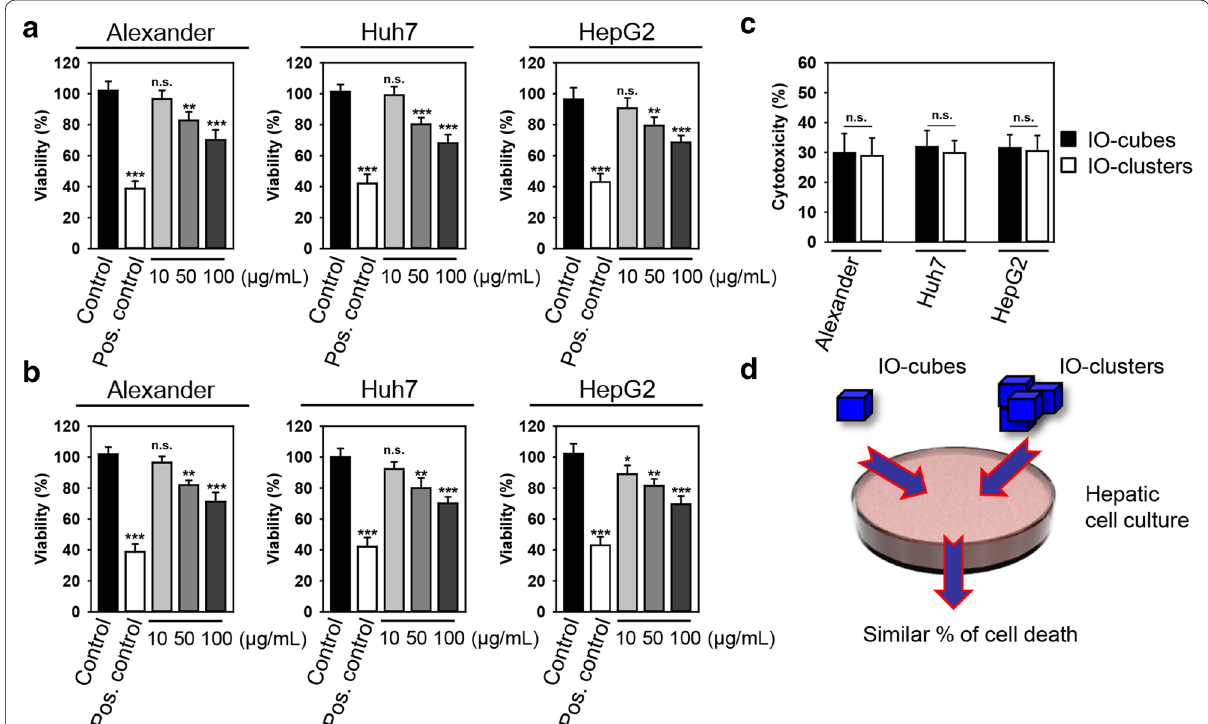
Fig. 3 Viability studies. Alexander, HepG2 and Huh7 cells were treated with indicated concentrations of either IO-cubes ( a ) or IO-clusters ( b ) for 48 h. The alamarBlue cell viability assay was used to assess degree of cellular viability. The data were normalized to control values (no particle exposure), which were set as 100% cell viability. Control cells were untreated. As a positive control, cells were treated with 20% ethanol for 60 min. Data are expressed as mean SEM (n 3), ** p < 0.01, *** p < 0.001. c Cell viability comparison among different hepatic cell lines as detected by the ± = alamarBlue cell viability assay. Cells were treated with 100 µg/mL of either IO-cubes or IO-clusters. d IO-cubes and IO-clusters reduce the viability of